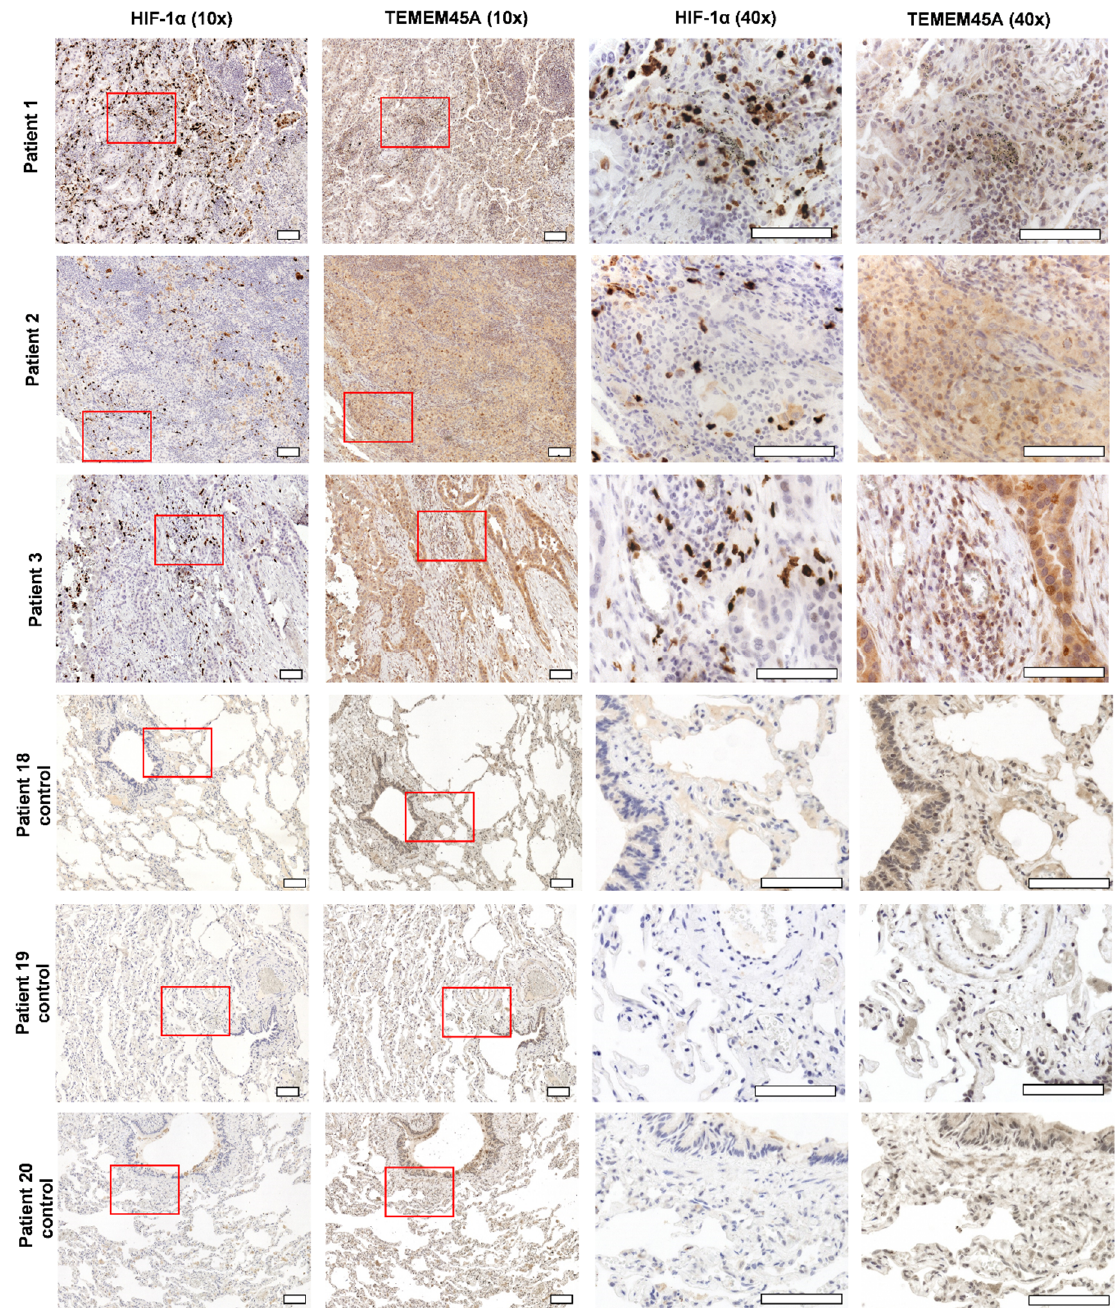
Figure 9. The immunohistochemistry showed high expression of TMEM45A and sporadic expression of HIF-1α in invasive acinar lung adenocarcinoma. An area of higher magnification (40× objective) within the presented image of the region of interest at lower magnification (10× objective) is indicated by a red box. Stages were the following: for patient 1, T1bN2M0; patient 2, T3N0M0; patient 3, T2bN2M0. Control tissues were derived from pneumothorax nontumorous patients. Scale bar: 100 µm.